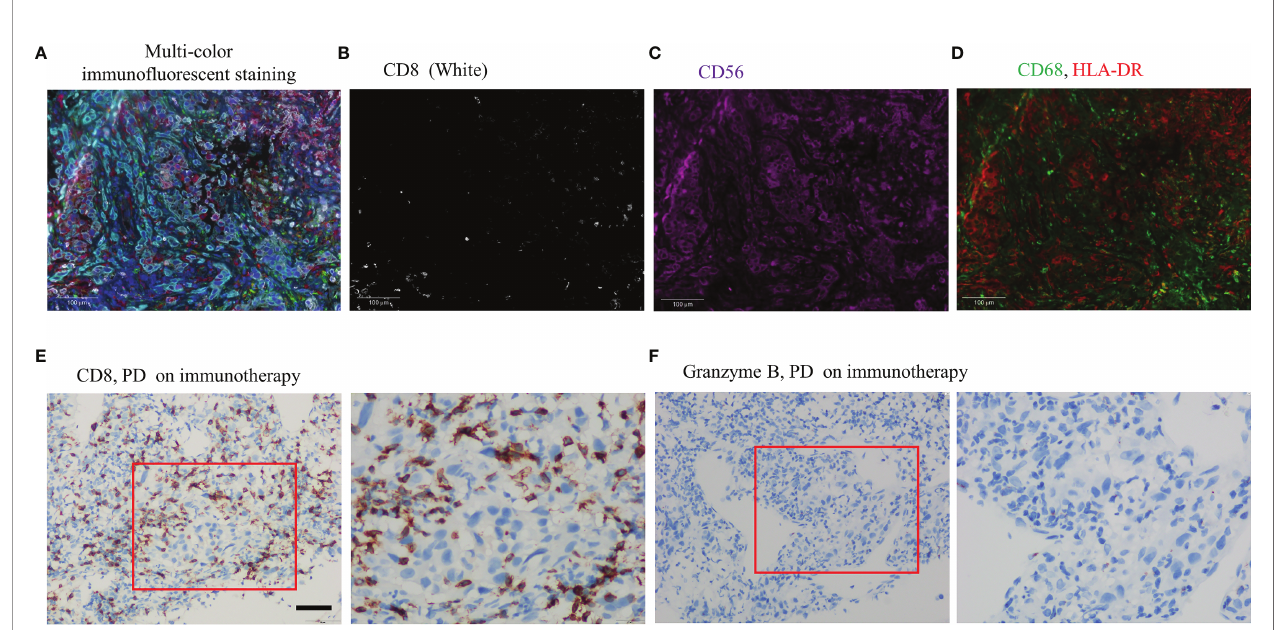
FIGURE 3 | Examinations of tumor microenvironment on tumor tissue sample as indicated. (A) Multi-color immuno fl uorescent staining of tumor microenvironment (white: CD8, purple: CD56, green: CD68, red: HLA-DR, cyan: panCK/S100, blue: DAPI) (magni fi cation ×200); (B) CD8 (white) (magni fi cation ×200); (C) CD56 (purple) (magni fi cation ×200); (D) CD68 (green), HLA-DR (red) (magni fi cation ×200); (E) Immunohistochemistry staining of CD8 with tumor tissue on disease progression of albumin-bound paclitaxel + carboplatin + nivolumab, Scale bar 50 um; (F) Immunohistochemistry staining of Granzyme B with tumor tissue on disease progression of albumin-bound paclitaxel + carboplatin + nivolumab, Scale bar 50